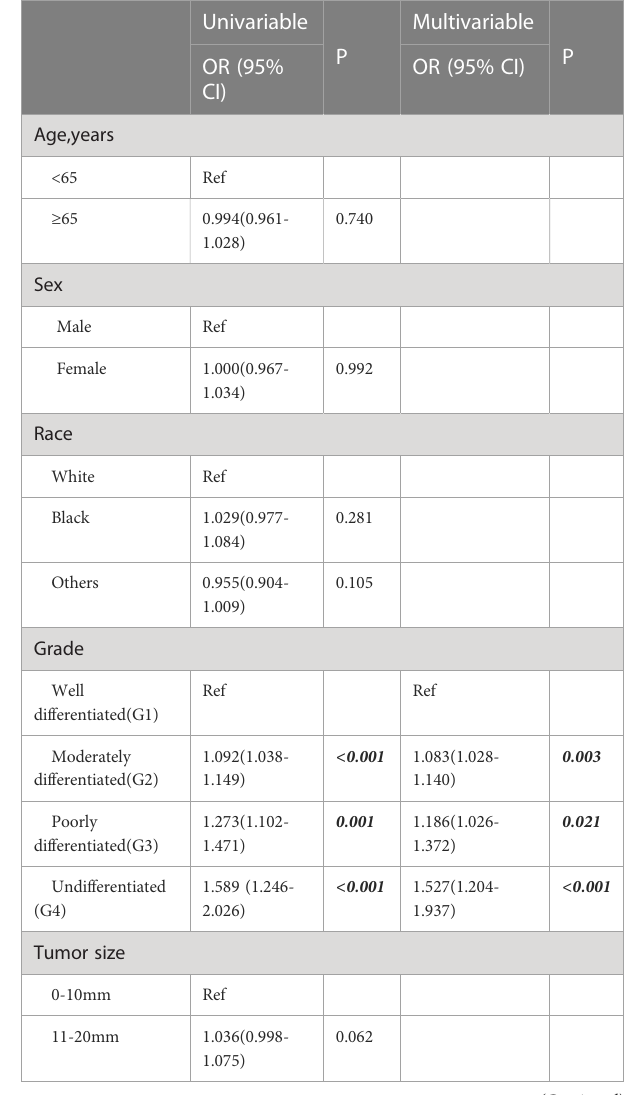
TABLE 2 Logistic regression analysis of clinicopathological factors associated with lymph node